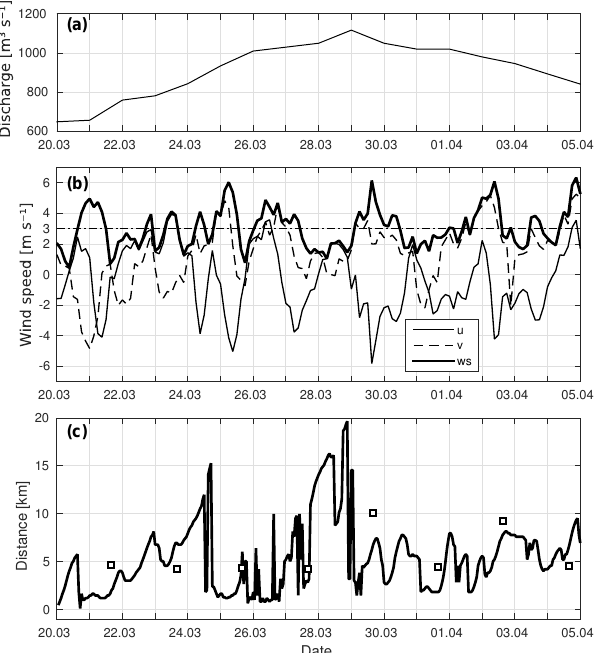
Figure 3. Time series of (a) daily mean Daugava River discharge; (b) 3h wind speed (bold), eastern (solid) and northern (dashed) wind components from the HIRLAM-ETA data set at Ruhnu, and 3ms − 1 wind speed (dash dotted); (c) offshore location of the max- imum salinity gradient from model (solid) and ship measurements (open square) for the period from 20 March to 5 April 2014. Dis- tance is measured along the ship track from the mouth of the Dau- gava